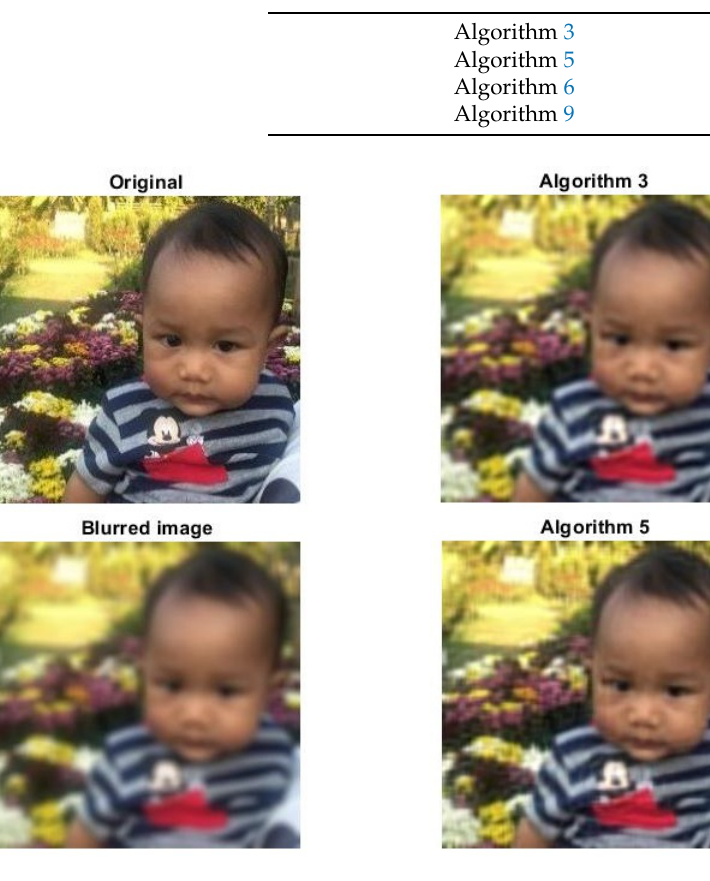
Figure 5. Deblurred images of each algorithm at the 200th